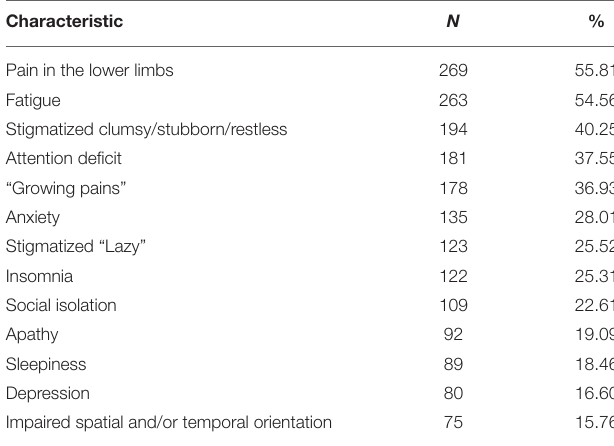
TABLE 6 | Absolute values and percentages of psychosocial characteristics in the total sample.